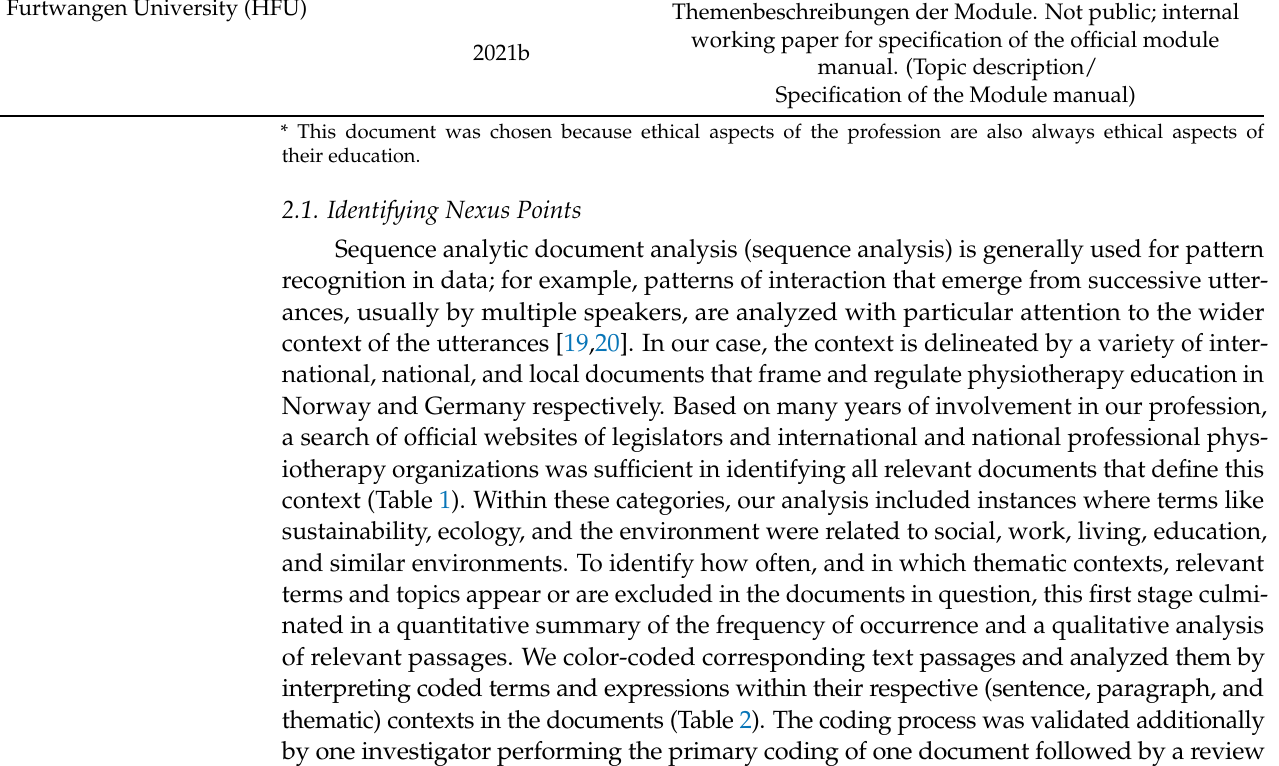
Themenbeschreibungen der Module. Not public;